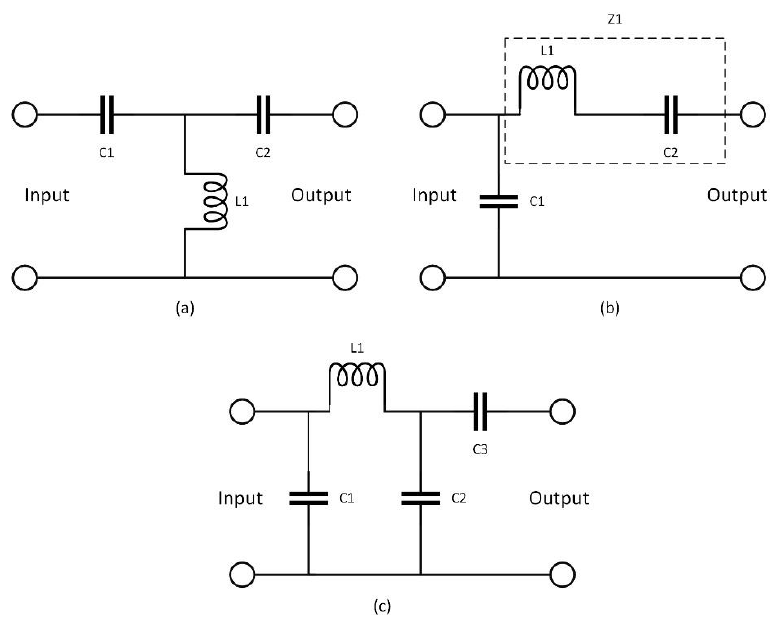
Figure 5. Different types of impedance matching networks with lumped elements: ( a ) T-Network ( b ) L-Network ( c ) π -Network.